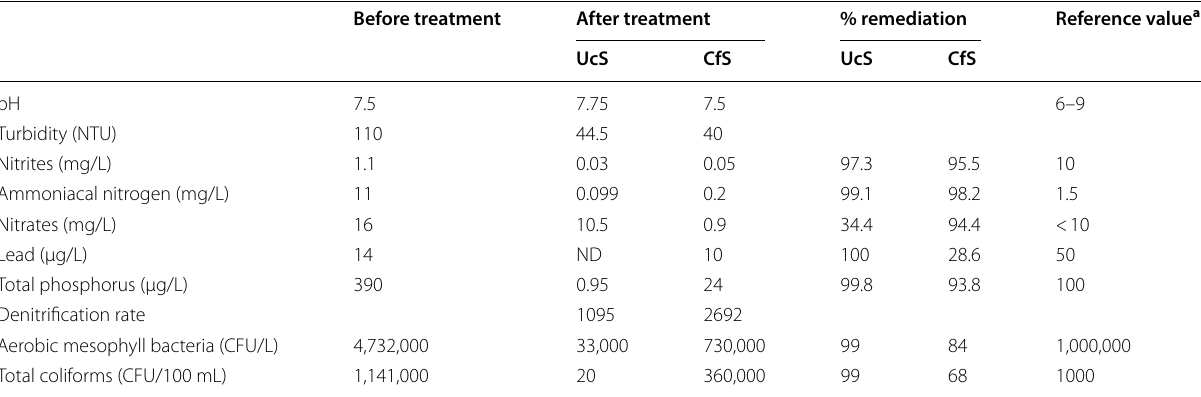
Table 3 Water physicochemical and microbiological properties before and after the